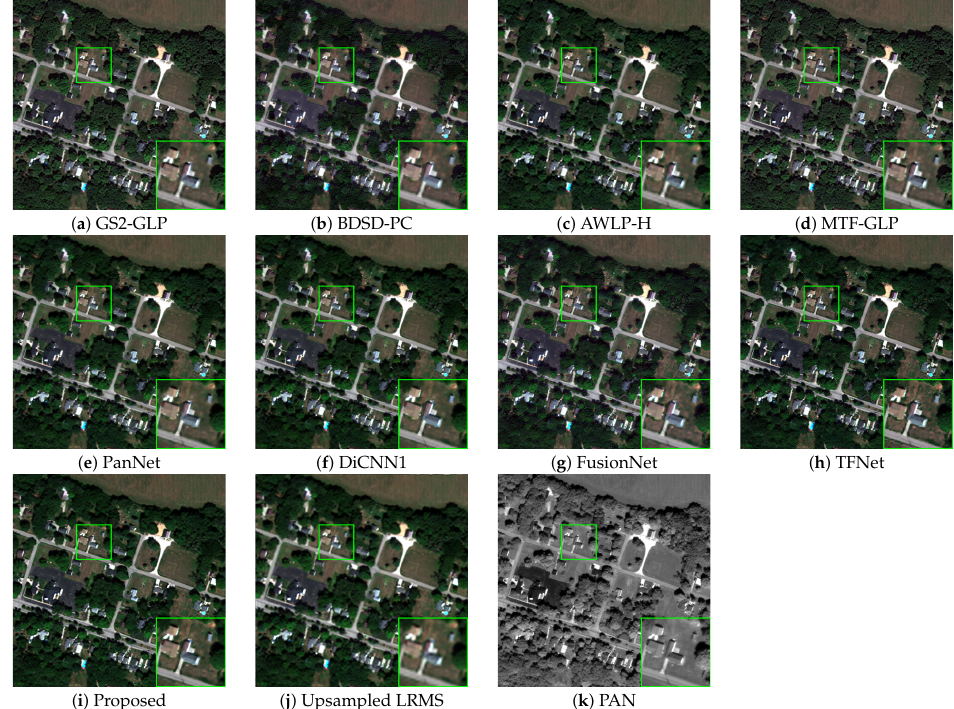
Figure 9. Fusion results of a group of full-resolution samples on the GeoEye-1